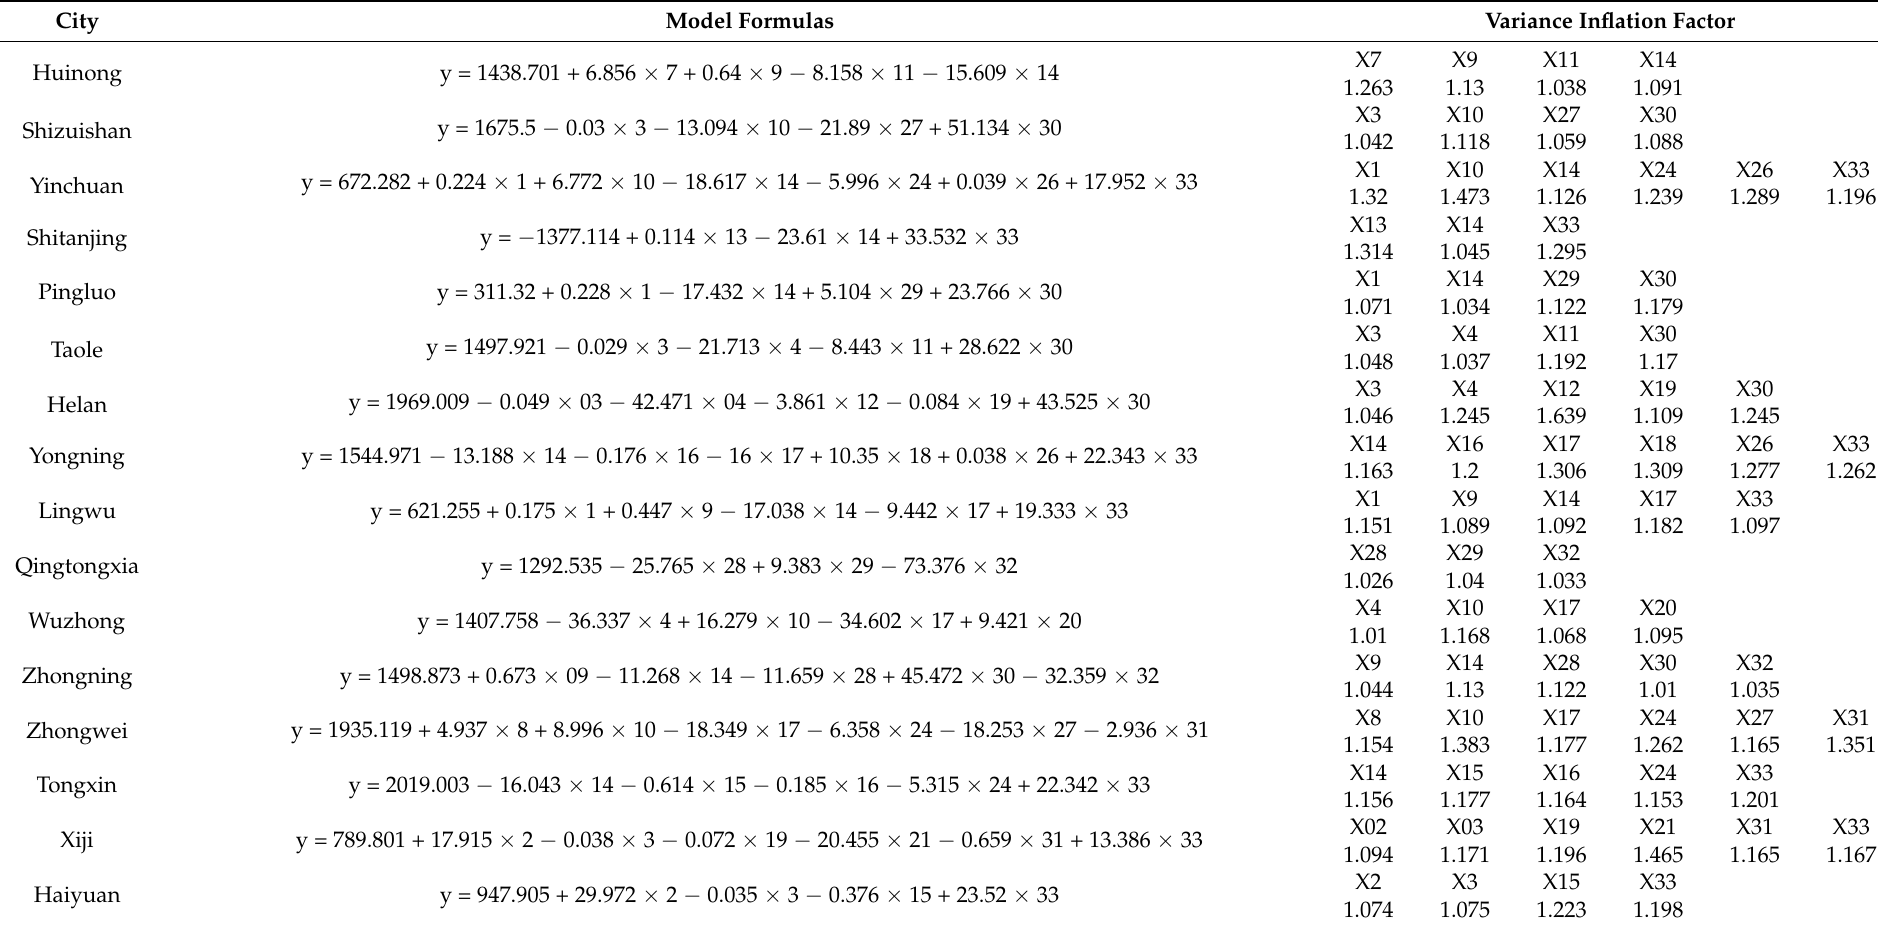
Table 2. Models built based on the atmospheric circulation index. Stepwise regression was used to select a suitable model through the expansion factor test (VIF <